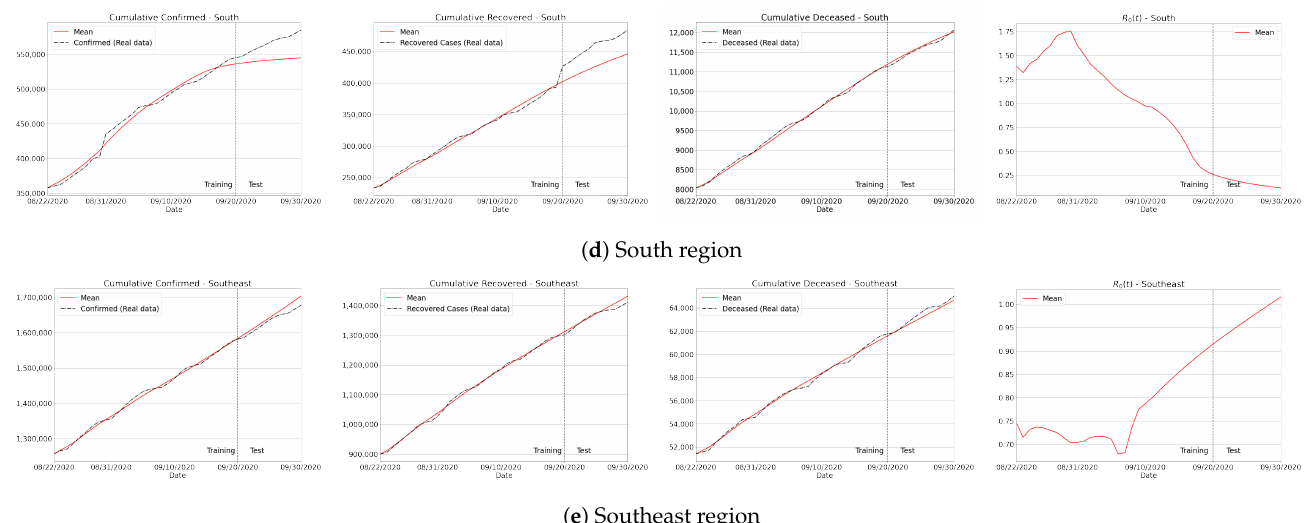
Figure A3. Forecasting results for Brazil’s regions.